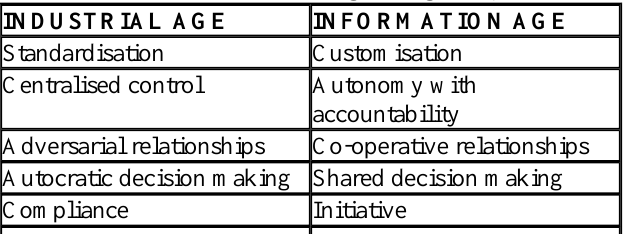
Table 1 Shift to an information age (Reigeluth, 1996)